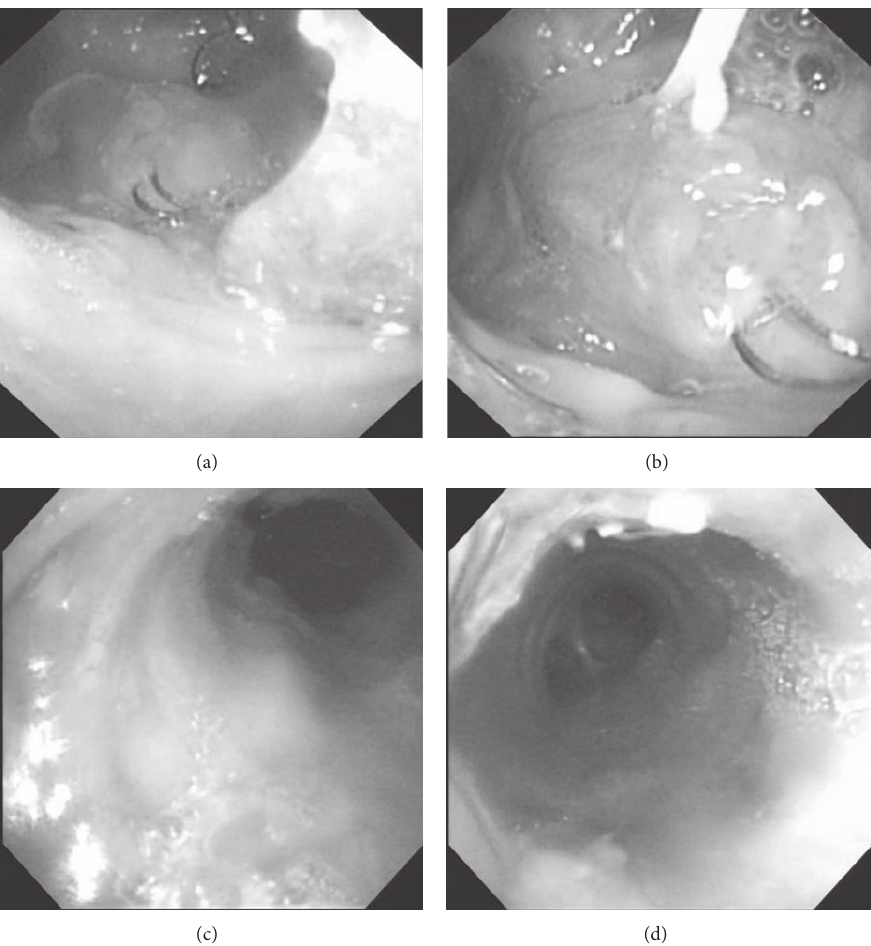
Figure 4: Bronchoscopy. (a) The top of the stent and the esophageal orifice were visible on bronchoscopy. (b) Food was emerging from the side of the granulation. (c) The area inside the stent was shown. (d) The trachea peripheral to the stent was also visible on bronchoscopy.